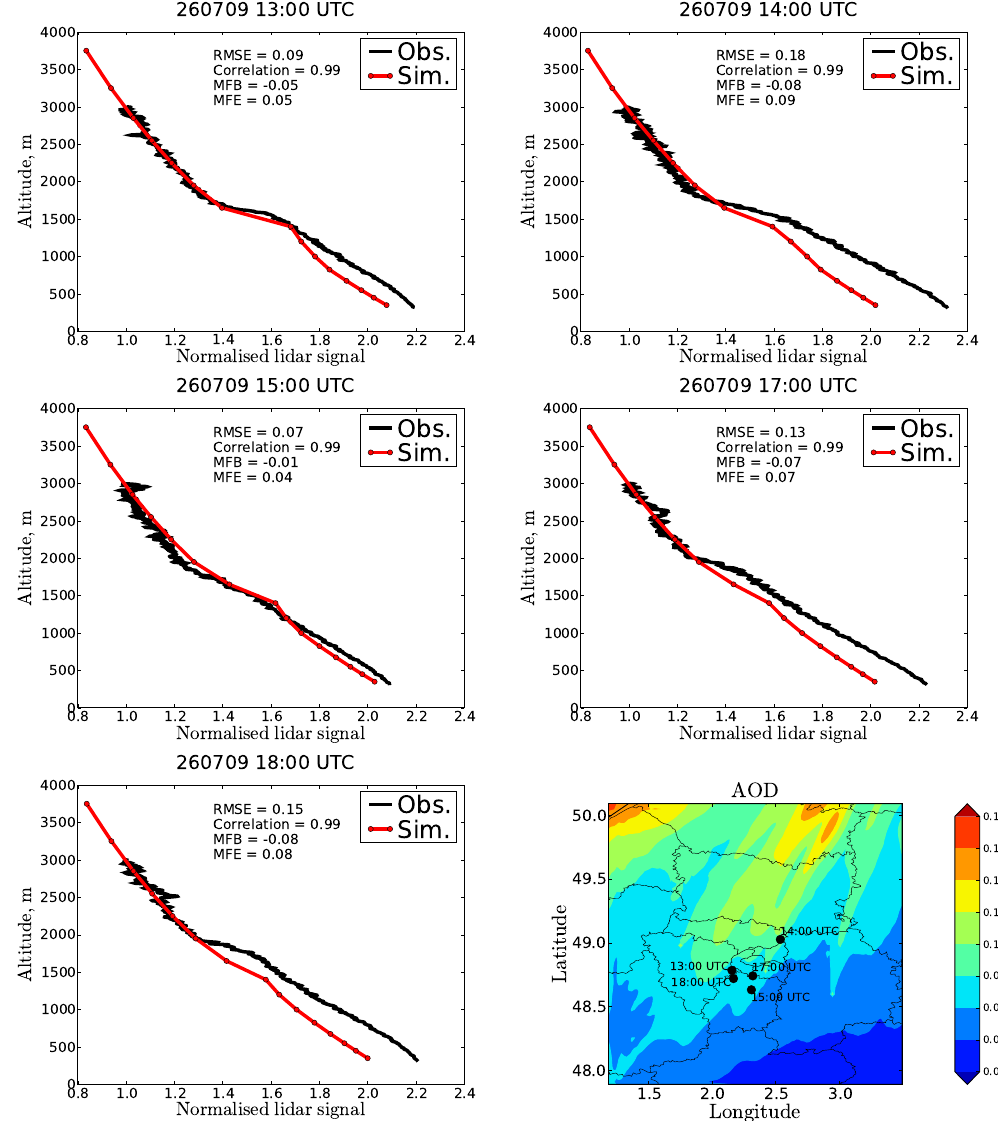
Fig. 8. Comparisons between the vertical profiles observed by GBML (black lines) and simulated by P OLYPHEMUS (red lines) on 26 July 2009 at 13:00, 14:00, 15:00, 17:00 and 18:00UTC. Lidar observations below the altitude of full overlap are not represented. The bottom-right panel shows the positions of the different lidar profiles and the horizontal distribution of the mean of the AODs at 13:00, 14:00, 15:00, 17:00 and 18:00 UTC.